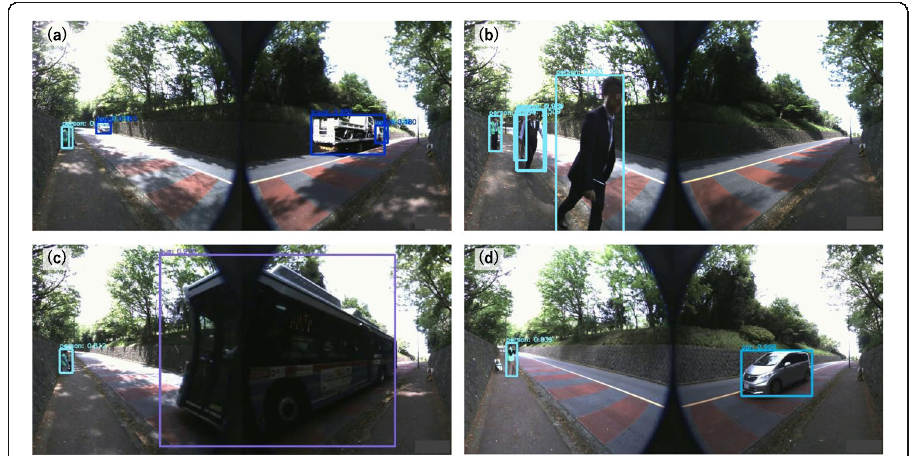
Fig. 3 The obtained image and detected object bounding-boxes. a one-truck, one-car, and one-person case; b four-person case; c one-bus and one-person case; and d one-car and one-person